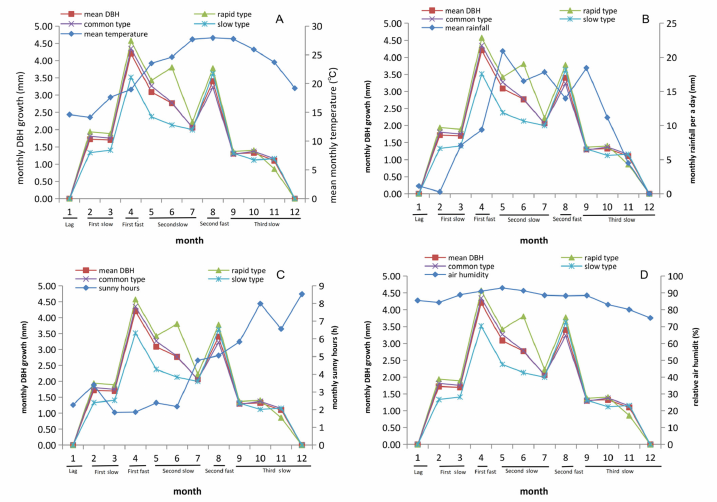
Figure 4. Dynamics of monthly DBH growth and meteorological factors including temperature ( A ); rainfall ( B ); sunshine hours ( C ); and relative humidity ( D ). Meteorological data were supplied by Gaoming Meteorological Bureau, Foshan City, Guangdong Province, China.